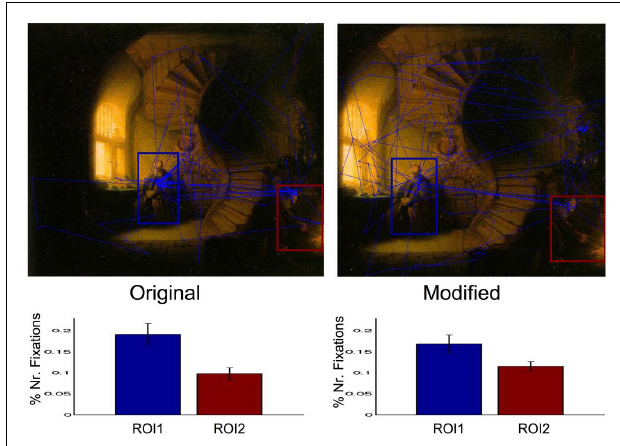
FIGURE 5 | Original (left) and modified version (right) of Piero della Francesca’s “Baptism of Christ” with the fixations of a subject superimposed. In the modified version the position of the dove was changed, eliminating the vertical symmetry axis of the original version, something that is clearly observed in the saccade patterns done by the subject.The bottom plot shows the average relative number of fixations in four regions of interest (ROI1 in blue, ROI2 in cyan, ROI3 in yellow, and ROI4 in